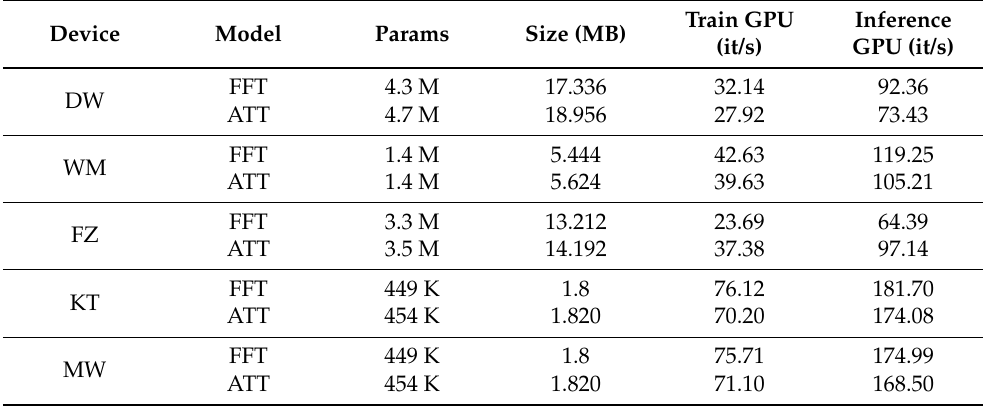
Figure 6. Benchmark results for the ablation study: ( a ) category 1: single building NILM; ( b ) category 2: single building learning and generalization on the same dataset. Table 5. Properties of the ablation study models for each appliance. Number of parameters, size of the model per device, training speed (GPU), inference speed